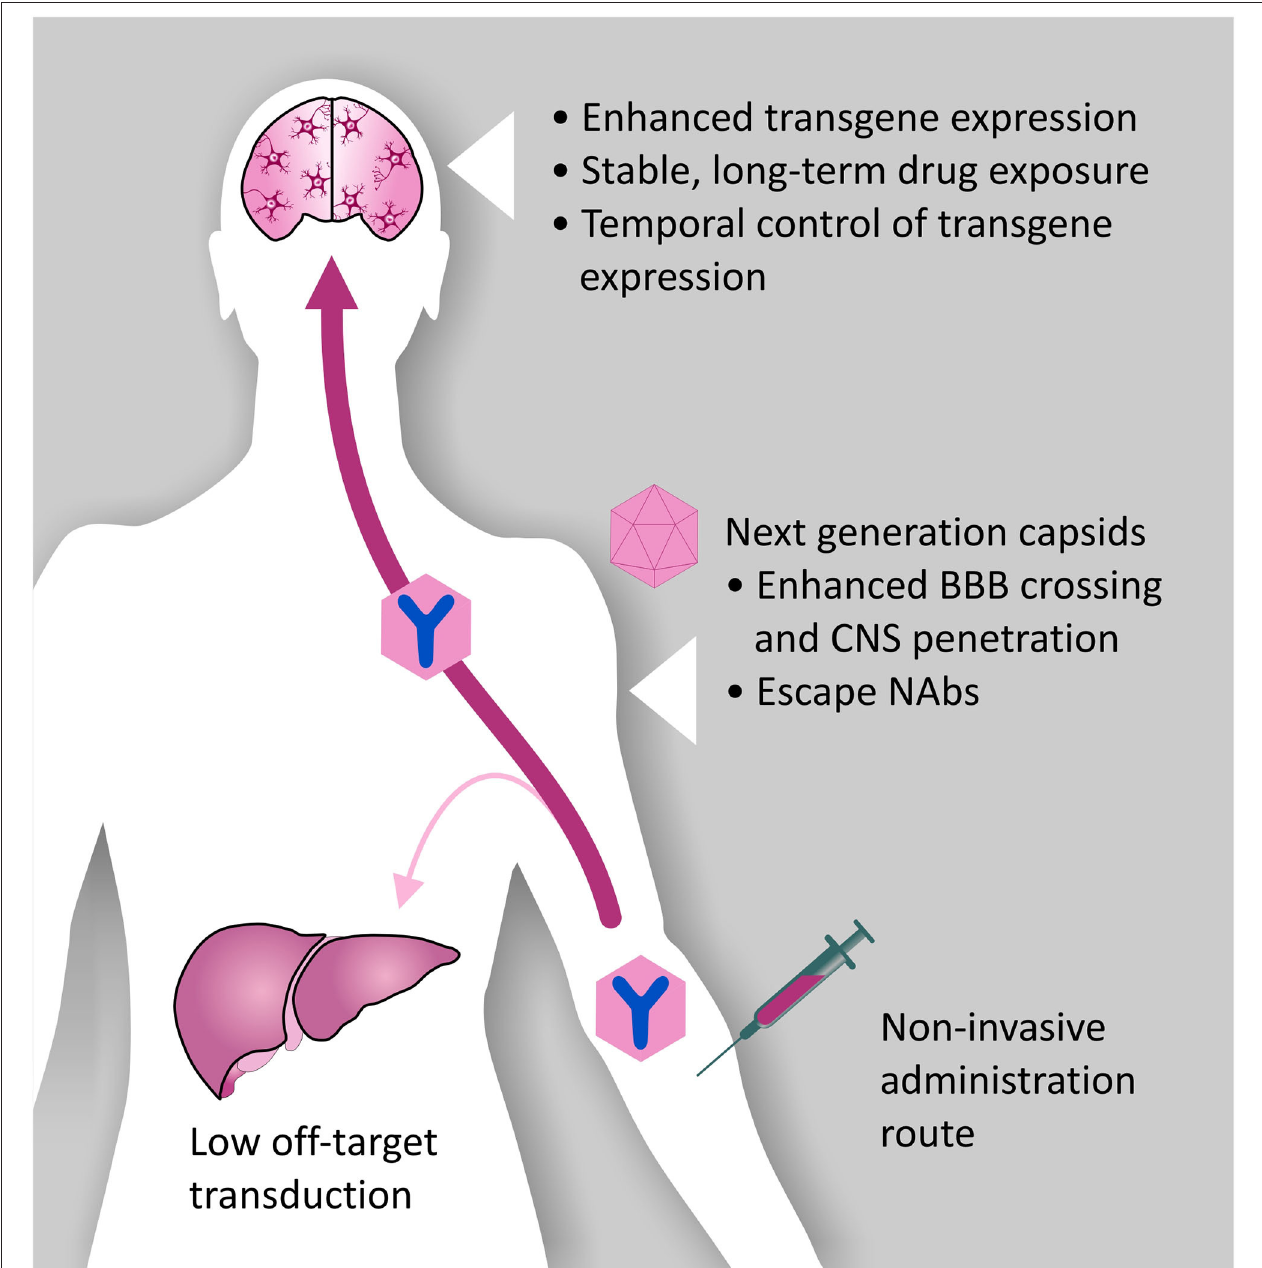
FIGURE 4 | Desired characteristics of rAAV vectors for A-MAD. Certain rAAV vector serotypes show BBB crossing properties, thus allowing minimally invasive and long-term delivery of mAbs and their derivatives within the CNS. However, improvements to the rAAV vector platform are desirable to maximize the therapeutic potential of A-MAD strategies, and decrease the risk of potential side effects. In particular, capsid engineering can be used to enhance BBB penetration, and enable CNS cell-type specific tropism. These modifications would also have the benefit of reducing potential off-target toxicity which, in the case of systemic administration, is usually linked to liver transduction. Introduction of capsid modifications is also desirable to reduce the likelihood of vector capture by pre-existing neutralizing antibodies (NAbs), which have been found to severely limit the efficiency of the system. In parallel, engineering of the rAAV transgene cassette is desirable to maximize transgene expression efficiency, thus allowing high (therapeutically relevant) levels of mAbs (or derivatives) within the CNS. Moreover, following systemic administration, it will be essential to spatially restrict transgene expression, de-targeting the periphery. The ability to turn transgene expression “on” or “off” will serve to prevent, or limit, adverse reactions to the transgene. Incorporation of such modifications into basic vector design will, in all likelihood, allow remaining concerns over the safety of AAV systems for CNS use to be overcome, while also increasing their therapeutic potential.